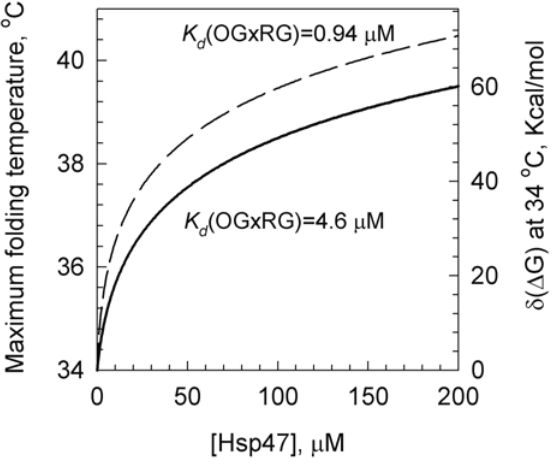
Figure 6. HSP47 may allow procollagen triple helix folding at normal and elevated body temperatures. The free energy of triple helix stabilization d ( D G ) and the corresponding maximum triple helix folding temperature T 0 + d T were calculated from Eqs. (5),(6) based on the HSP47 binding sites and dissociation constants reported in [40], as described in Methods (Theoretical analysis). Two possible values of the dissociation constant K d (OGxRG)=4.6 m M (solid line) and K d (OGxRG)=0.94 m M (dashed line) were used to account for the uncertainty in HSP47 binding at OGxRG, where x is a variable amino acid.